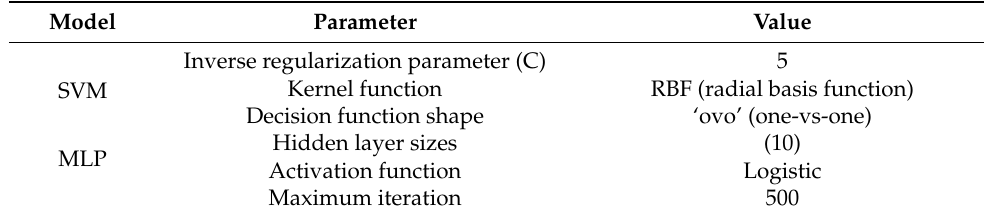
Table 3. Tuned hyperparameters for classification models.